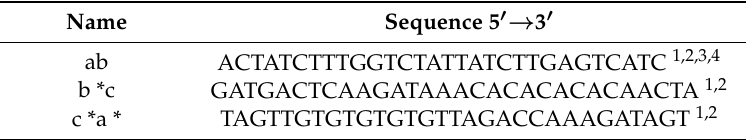
Table 1. Oligonucleotide sequences (30 nucleotides) to form DNA trimers. Part a is complementary to a *; b to b * and c to c *. Different variations of DNA sequences were used (see